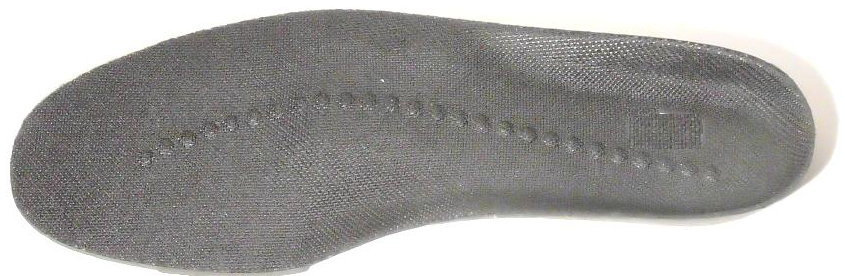
Figure 4. Example of texture installation to guide the CoP (WO2016015091A1—Injury Reduction Insole).